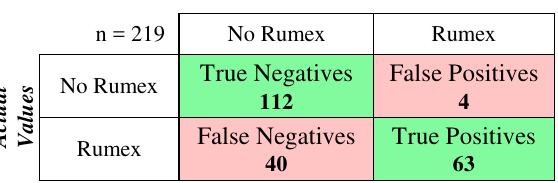
Figure 11. Confusion Matrix – Classification of Rumex location moved using the basic trained model.